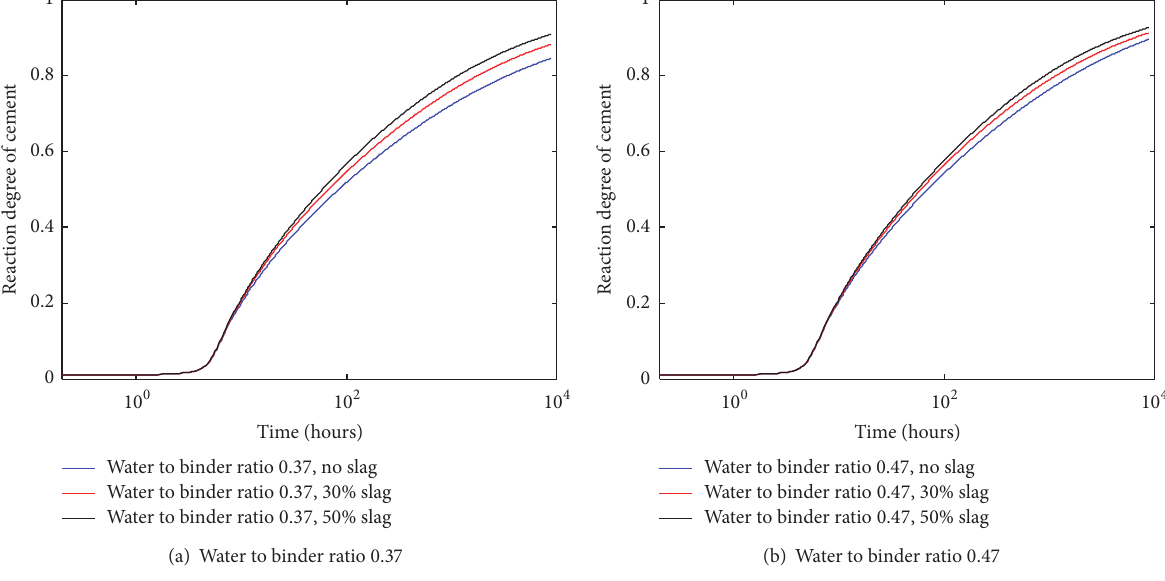
Figure 1: Reaction degree of cement.